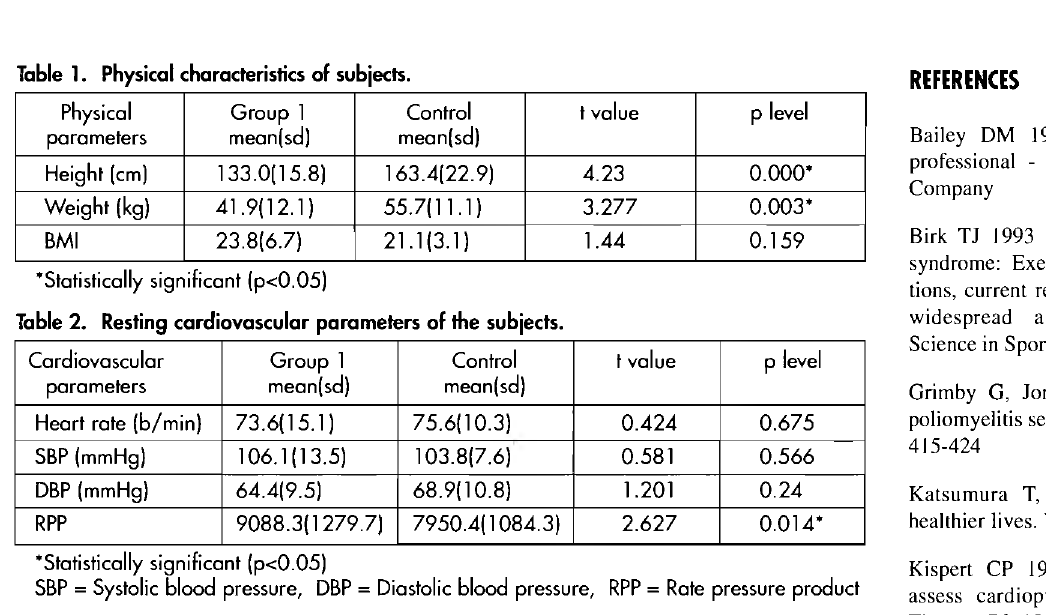
Table 3. Immediate post exercise cardiovascular parameters. Cardiovascular